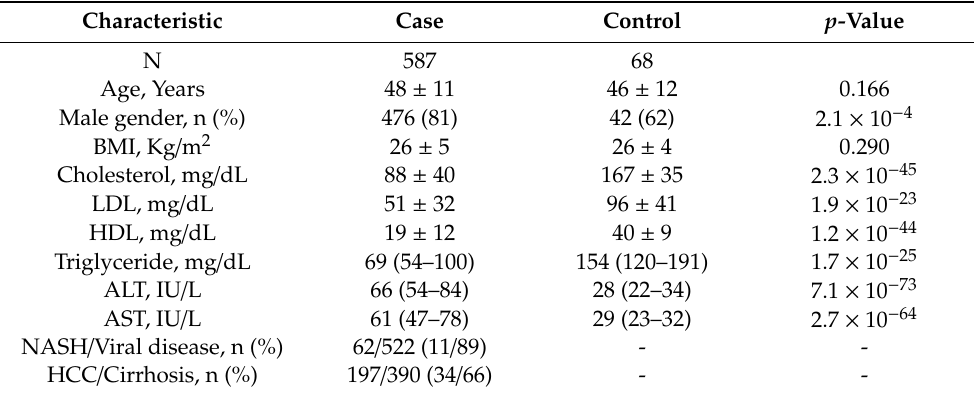
Table 1. Clinical characteristics of the two study